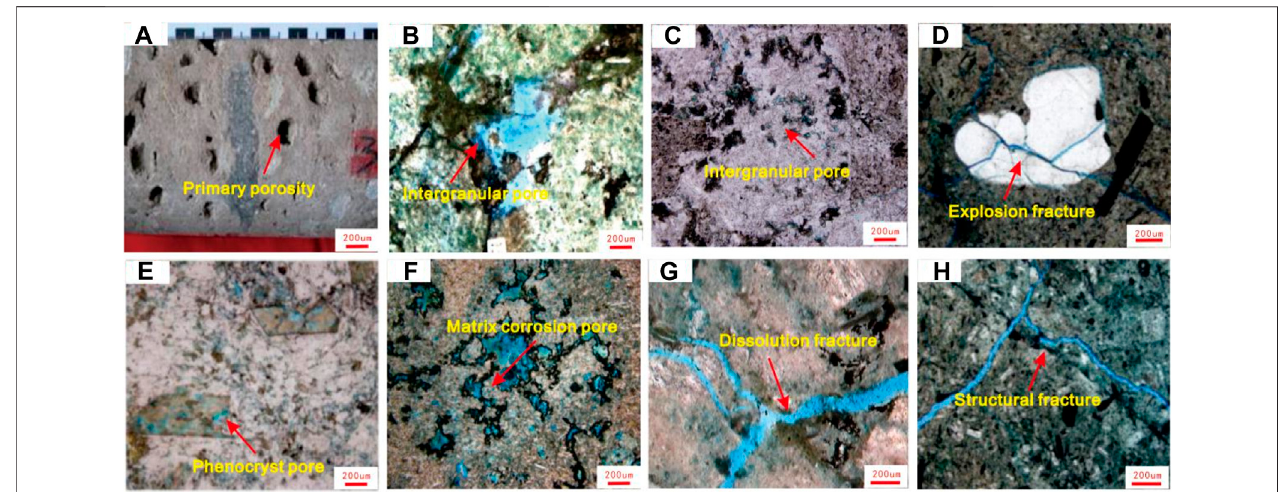
FIGURE5| Genetictypesofvolcanicrock reservoirspaceintheWangfu gas fi eld. (A) Primarypores, rhyolite,wellCs14,2,997.75 m,core; (B) intergranularpores, rhyolite breccia, wellCs13, 2232mm, single polarized light×10; (C) intergranular pores, gray andesite, wellWf1, 3130m, single polarized light ×10; (D) explosion fracture, trachycere breccia lava, well Cs11, 3043m, single polarized light ×10; (E) porphyry pores, trachyandesite, wellWf1, 3230 m, single polarized light×10; (F) matrix corrosion pore, volcanic breccia, wellCs602, 2,614.8 m, single polarized light×10; (G) dissolution fracture, trachyandesite, wellCs11, 2720 m, single polarized light×10; and (H) structural fracture, trachoic breccia lava, wellCs11, 3043m, single polarized light×10.